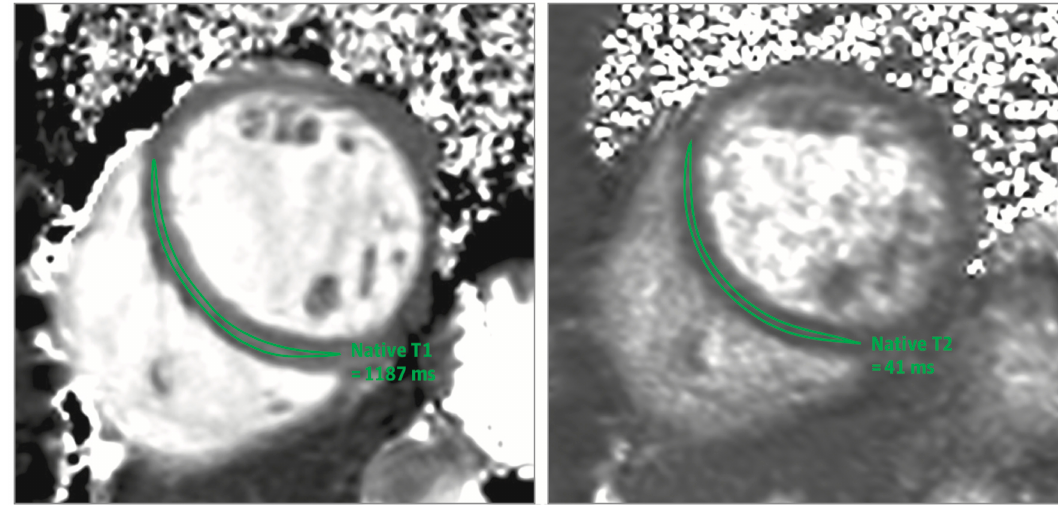
Figure 4. Quantitative parametric myocardial T1 and T2 mapping in COVID-19 showing significantly raised native T1 and native T2 in an adult woman with acute COVID-19 perimyocarditis. In this study, abnormal native T1 and T2 values were defined as greater than 1105 ms and greater than 37.4 ms, respectively, based on previously derived sequence-specific cutoffs of 2 SDs above the respective means in a healthy population [55].